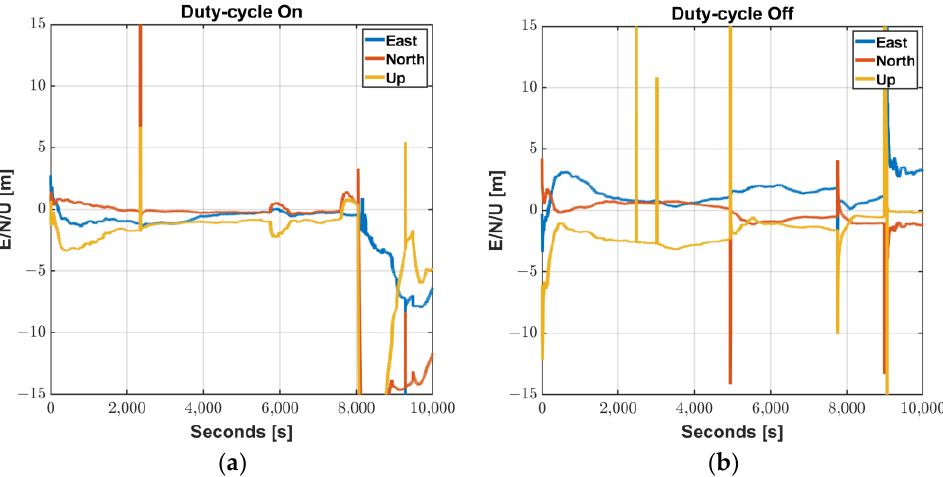
Figure 5. RTKLIB Processing Results of Mi8 L1/L5 GPS Measurements: ( a ) Duty-cycle On; ( b ) Duty- cycle Off. ( b ) Duty-cycle